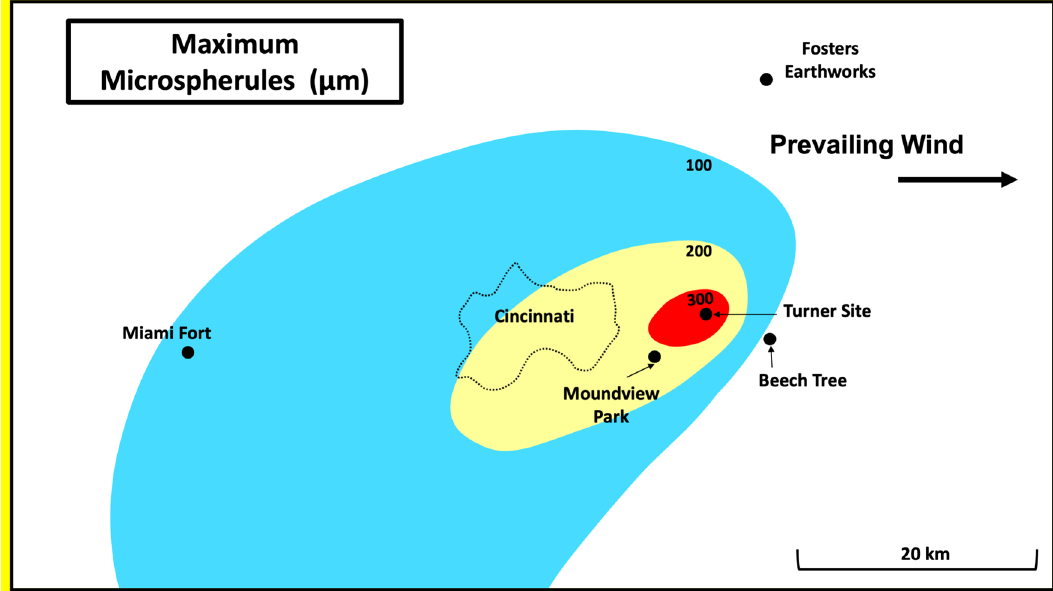
Figure 24. Geographic distributions of the maximum size of microspherules. Stephen Meyers and Stephanie Meyers used Microsoft PowerPoint for Mac Version 16.41 (www. micro soft. com) to create this figure.